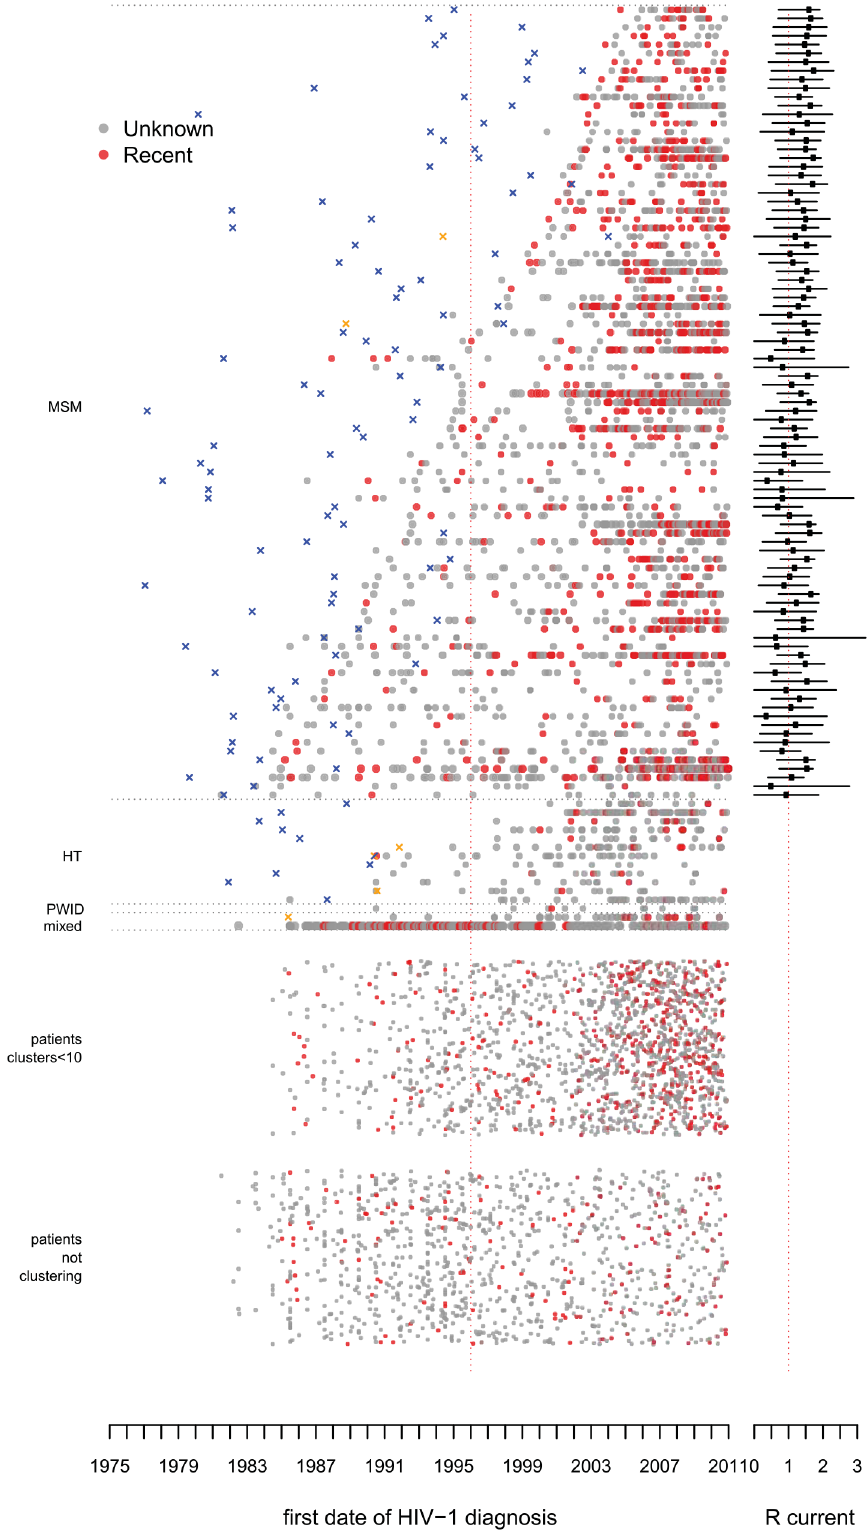
Fig 5. Large transmission clusters over time: recent infections. As in Fig 2, but here red dots represent patients with a documented recent infection. HT, heterosexual transmission.